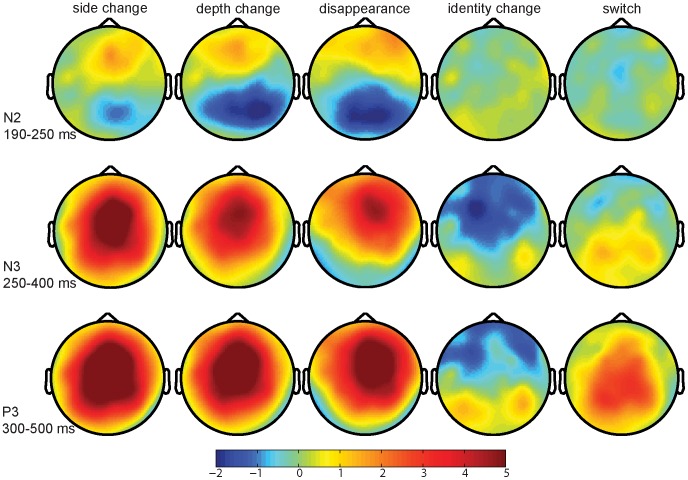
Scalp distributions of ERP effects (change minus match) for N2, N3, and P3 latency windows.